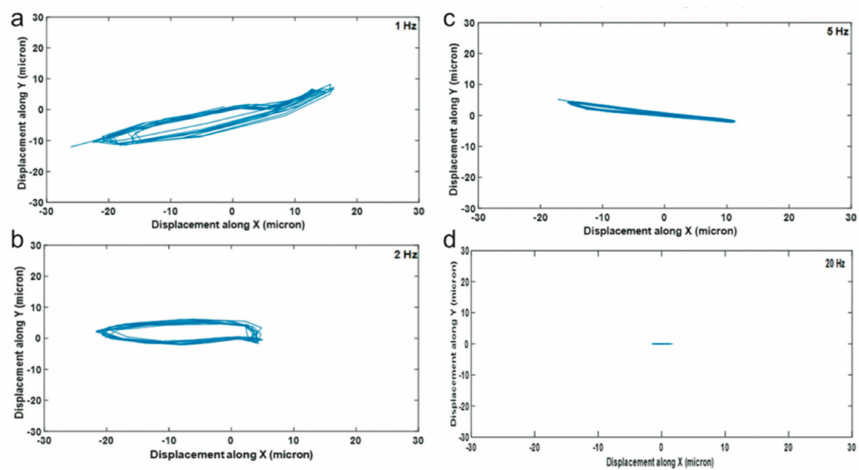
Figure 8. Actuating the acoustic trap with a frequency sweep will move a levitated chondrocyte cell aggregate laterally. The displacement can be controlled by the sweep rate, providing a means to control the mechanical stimulation during tissue formation. In the figure, the aggregate position along x and y directions over time is measured at the sweep rates 1 Hz ( a ), 2 Hz ( b ), 5 Hz ( c ) and 20 Hz ( d ) Reprinted with permission from [23] published by the Royal Society of